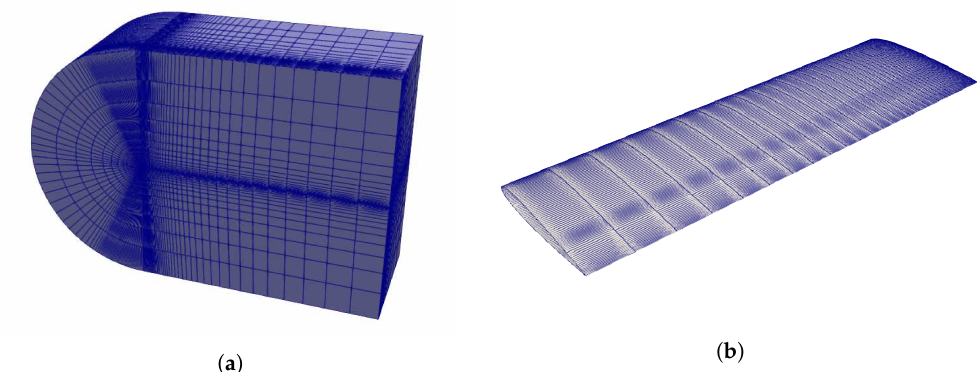
Figure 5. Mesh for the rectangular wing geometry. ( a ) Far field view. ( b ) Wing surface mesh. Table 1. Grid independence study for the